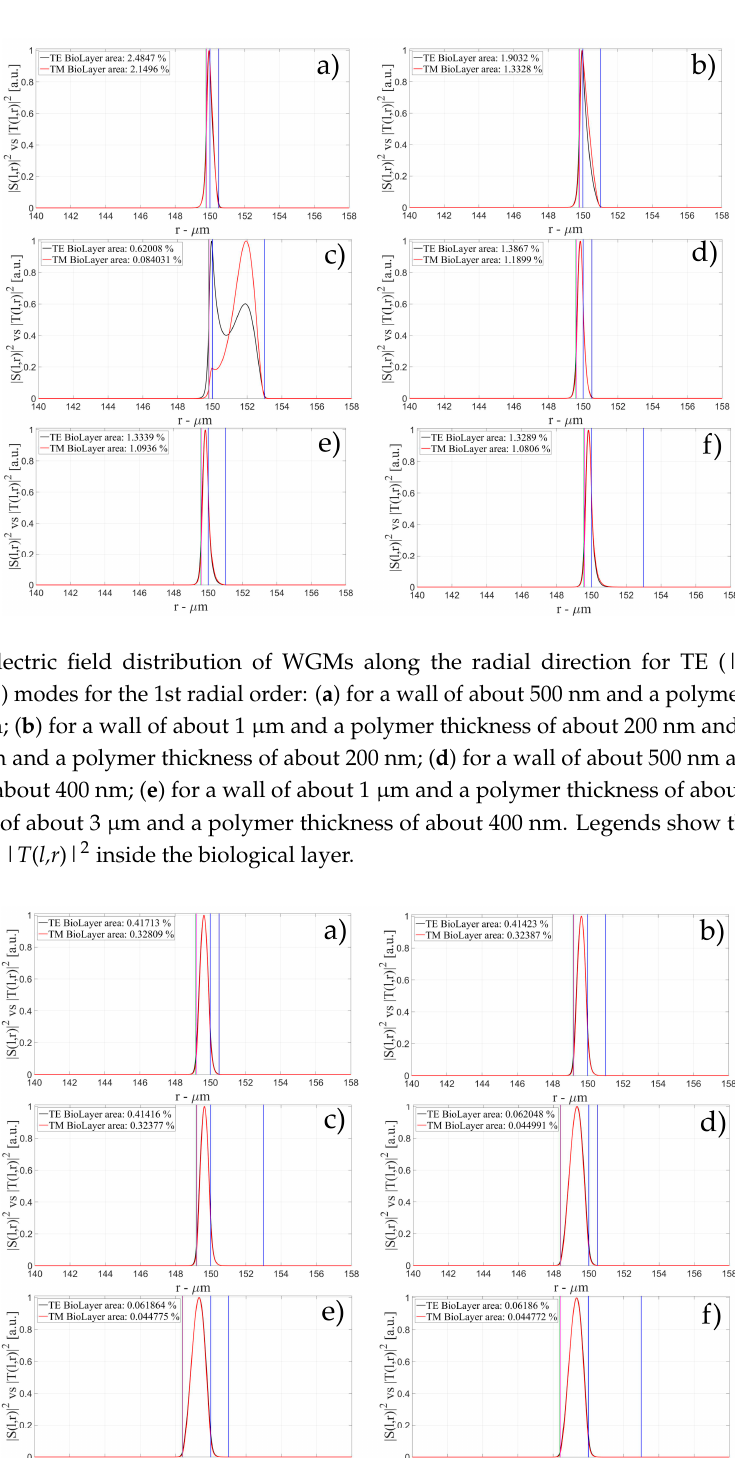
Figure 9. Electric field distribution of WGMs along the radial direction for TE (| S ( l,r ) | 2 ) and TM (| T ( l,r ) | 2 ) modes for the 1st radial order: ( a ) for a wall of about 500 nm and a polymer thickness of about 800 nm; ( b ) for a wall of about 1 μ m and a polymer thickness of about 800 nm and ( c ) for a wall of about 3 μ m and a polymer thickness of about 800 nm; ( d ) for a wall of about 500 nm and a polymer thickness of about 1600 nm; ( e ) for a wall of about 1 µ m and a polymer thickness of about 1600 nm and ( f ) for a wall of about 3 µ m and a polymer thickness of about 1600 nm. Legends show the fraction of | S ( l,r ) | 2 and | T ( l,r ) | 2 inside the biological layer.